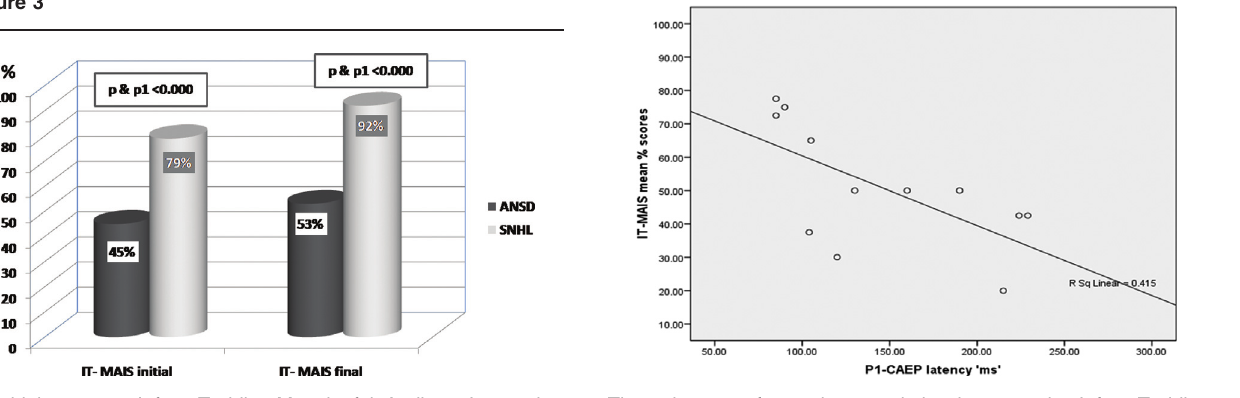
The existence of negative correlation between the Infant Toddler Meaningful Auditory Integration Scale (IT-MAIS) scores and the P1 cortical auditory evoked potential (P1 – CAEP) latency in children with auditory neuropathy spectrum disorder